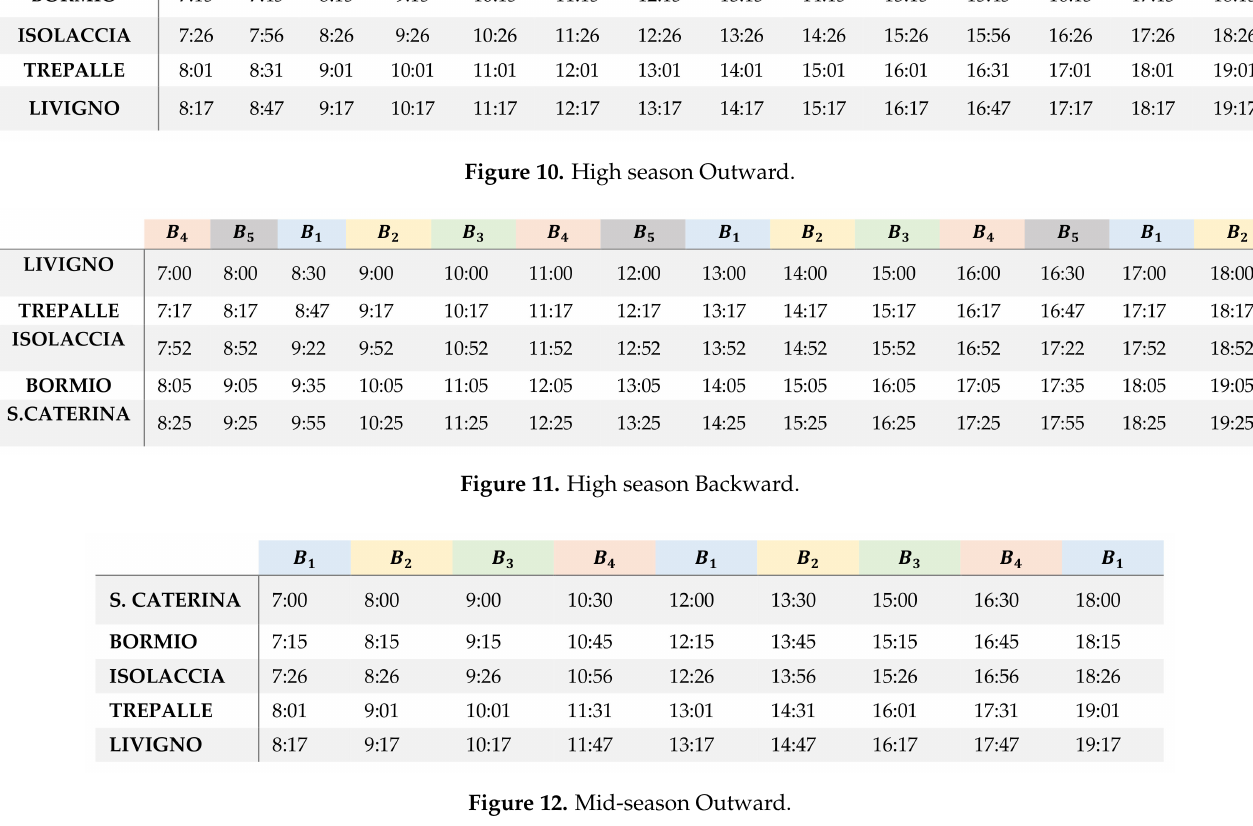
Figure 12. Mid-season Outward.